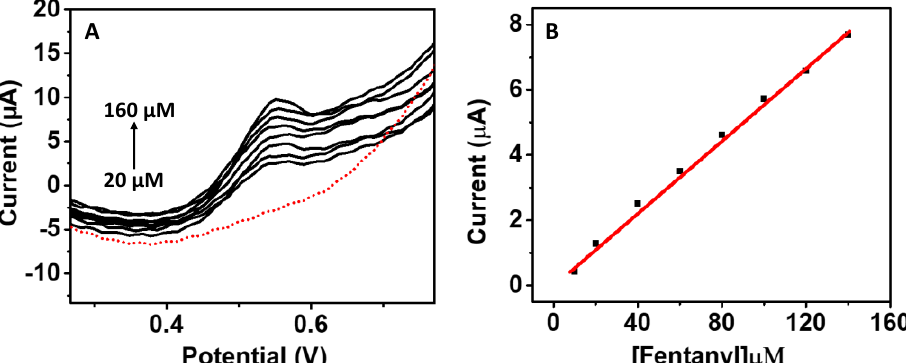
Figure 3. Calibration curve of fentanyl in buffer solution using microneedle sensor platform. Figure ( A ) illustrates SWV response of increasing fentanyl (20–160 µ M, each 20 µ M addition) concentrations in buffer solution; the red dotted curve presents buffer baseline current response and other black curves illustrate the fentanyl oxidation curve on polymeric microneedle surface. Figure ( B ) shows the obtained current response (baseline subtracted) from the fentanyl calibration (20–200 µ M). The SWV parameters were an equilibrium time of 2 s, a potential range of 0–1.0 V, an E step of 0.01 V, and a frequency of 10 Hz; the experiments were performed at room temperature.